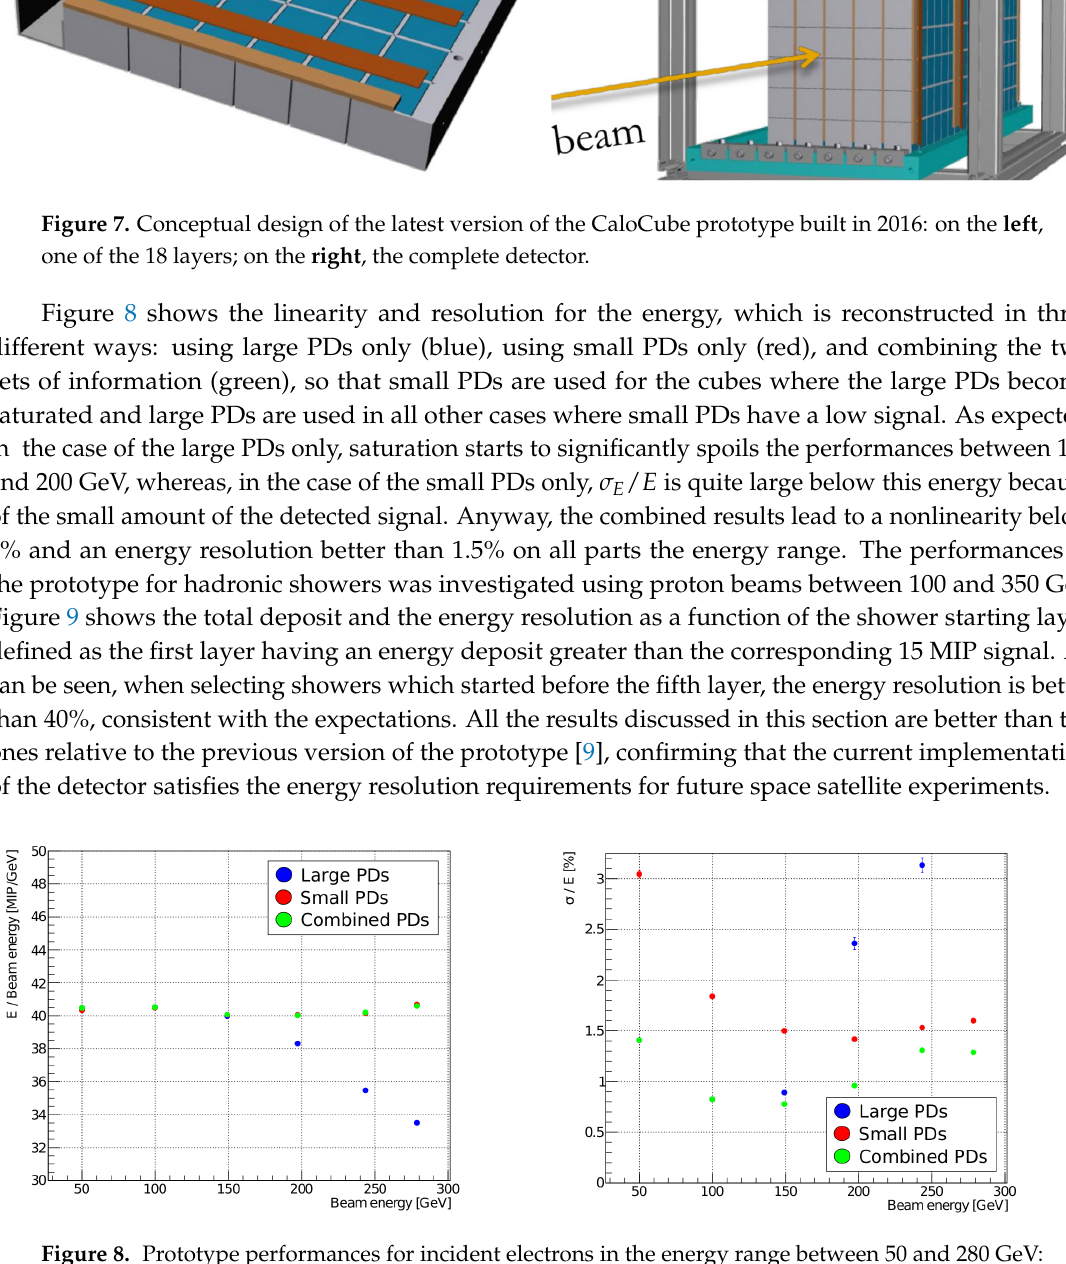
Figure 8. Prototype performances for incident electrons in the energy range between 50 and 280 GeV: Average deposit/beam energy ( left ) and energy resolution ( right ). The energy is reconstructed using large photodiodes (PDs) only (blue), small PDs only (red), or by combining the two sets of information